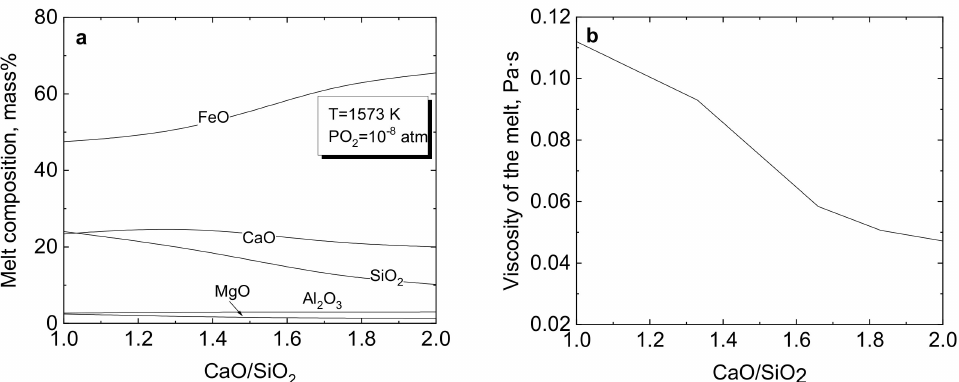
Figure 10. ( a ) Composition of the liquid melt formed at 1573 K and oxygen partial pressure of 10 − 8 atm and ( b ) the viscosity of the melt under various sinter